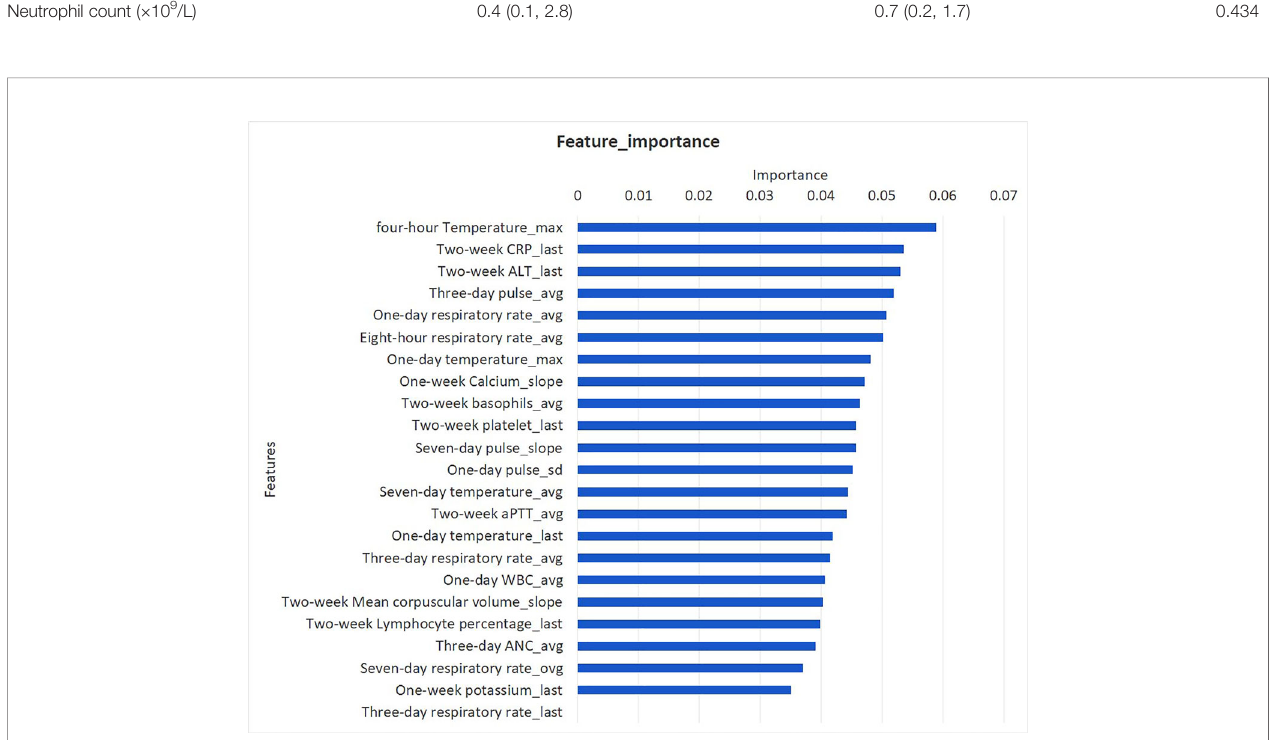
FIGURE 5 | Feature importance derived from XGBoost model in 24 h